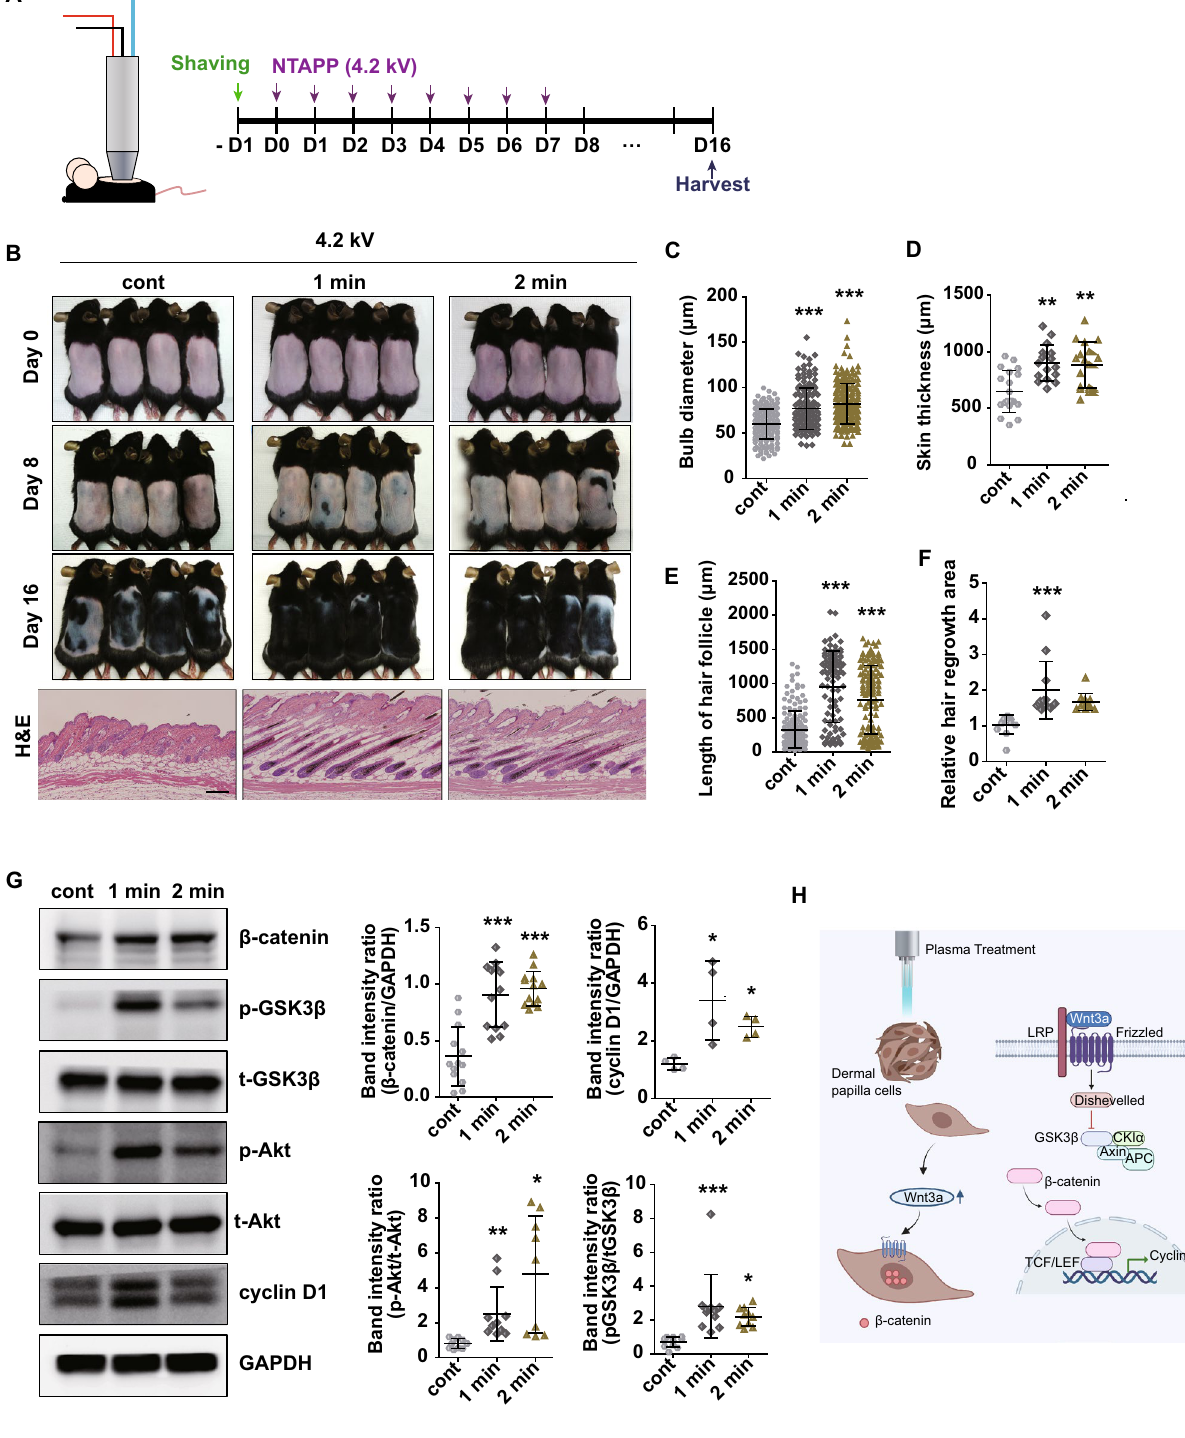
Figure 4. NTAPP stimulates the Wnt/β-catenin pathway and enhances hair regrowth in a mouse model. ( A ) The back skins of 7-week-old female C57BL/6 mice ( n = 5–6 per group, three independent experiments) were shaved and treated with NTAPP (4.2 kV) for 1 or 2 min on 7 consecutive days. ( B ) Gross images of mouse dorsal skin on day 0, 8 and 16 days after the start of NTAPP treatment (top panels); hematoxylin and eosin (H&E) staining of the mouse back skins (lower panels, scale bar = 200 μm). ( C – F ) Histological analysis of bulb diameter, skin thickness, hair follicle length, and relative hair regrowth area. ( G ) Western blot analysis of β-catenin, GSK3β, AKT, and cyclin D1 levels in NTAPP-treated mouse skin. ( H ) A graphical summary of results. All results presented are representative of at least three independent experiments. p values were determined by one-way ANOVA. * p < 0.05, ** p < 0.01, *** p < 0.001 (vs. control). The original uncropped images for g are available in Supplementary